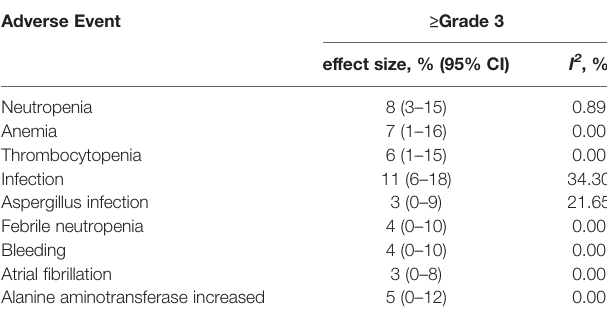
TABLE 3 | Pooled results of common AEs of ≥ grade